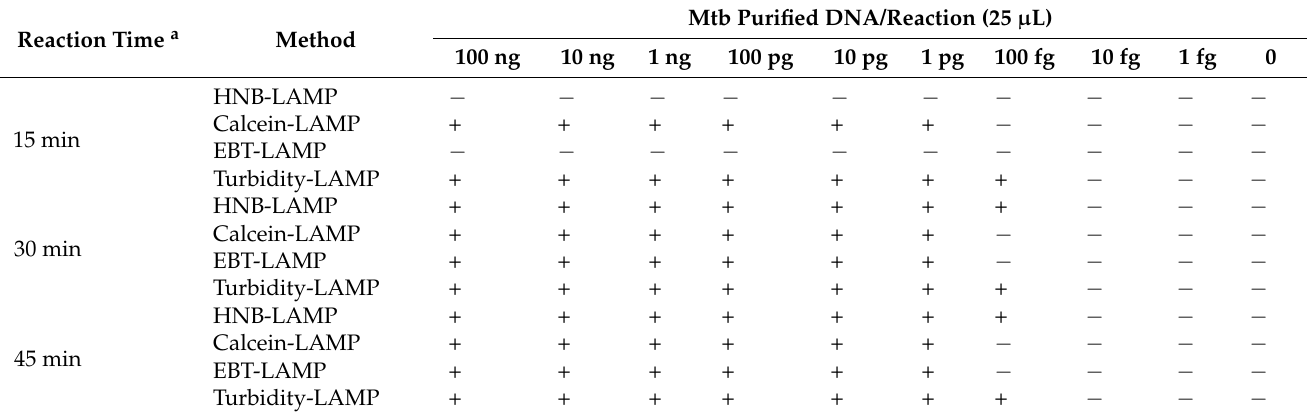
Table 2. LAMP monitoring methods performed on various DNA concentrations/reaction with different duration times of reaction for the determination of the optimal reaction time capable of detecting the lowest amount of the Mtb